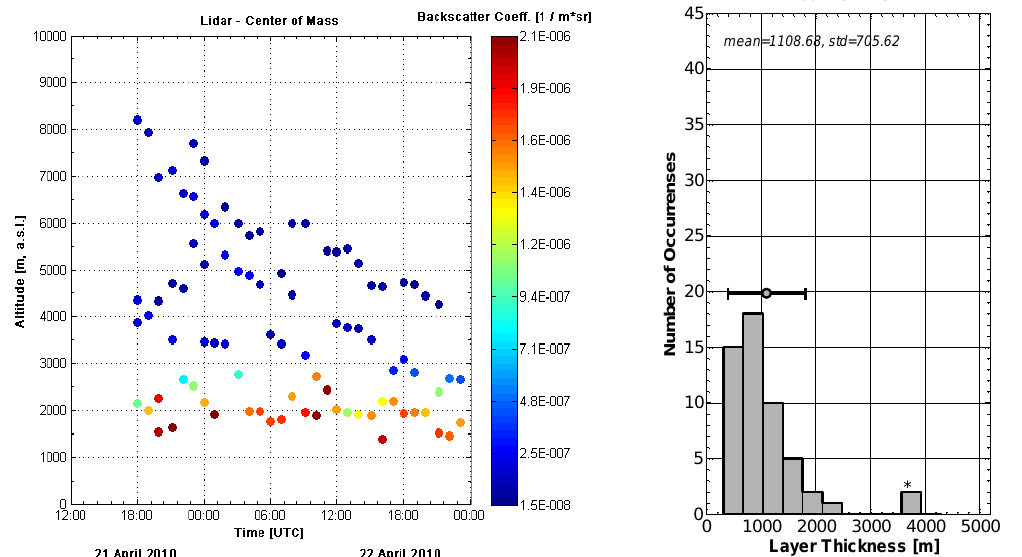
Fig. 3. Left panel: center of mass (CoM) of the volcanic ash layers, as detected by Raman lidar measurements over Athens (hourly averaged data) according to the aerosol backscatter coefficient (in m − 1 sr − 1 ) at 532nm for the period 21 April 2010 (12:00UTC) and 23 April 2010 (00:00UTC). Right panel: volcanic aerosol layer thickness distribution (in m) according to Raman lidar measurements for a center of mass (CoM) >3km height for the period 21 April 2010 (12:00UTC) and 23 April 2010 (00:00UTC) over Athens. The dot corresponds to the position of the mean value of the aerosol layer thickness, while the error bar corresponds to the standard deviation of the distribution.